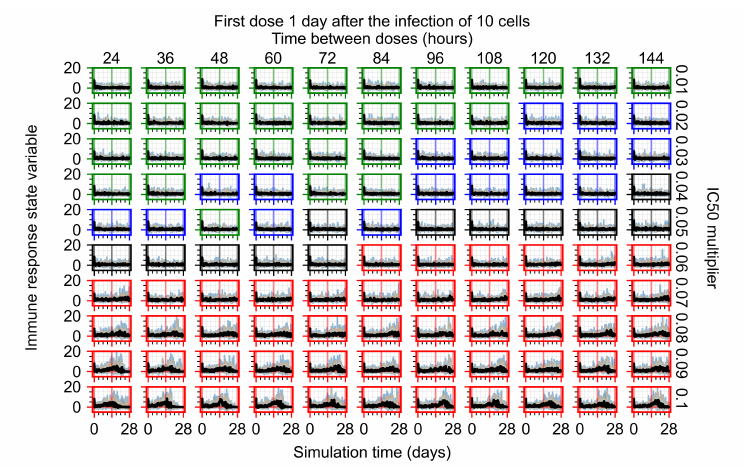
Figure A115. Immune response state variable number. Positive values correspond to an inflammatory state, and negative to an anti-inflammatory